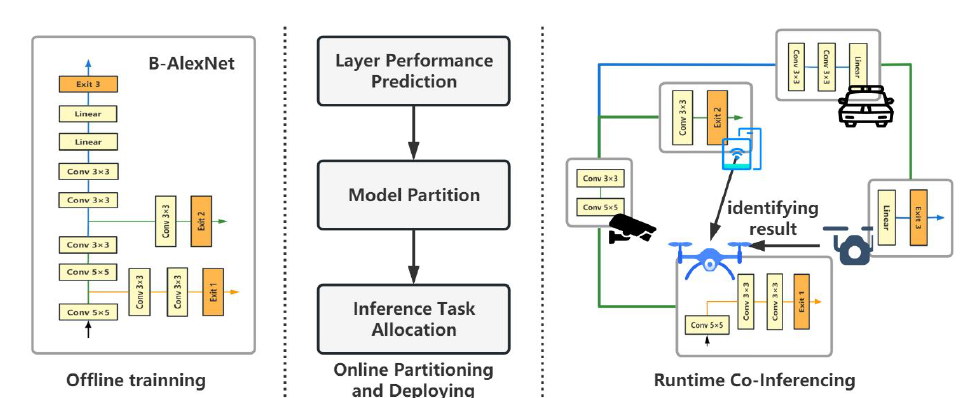
Figure 2. The basic process for partitioning and distributing inference tasks contained in an intelligent edge